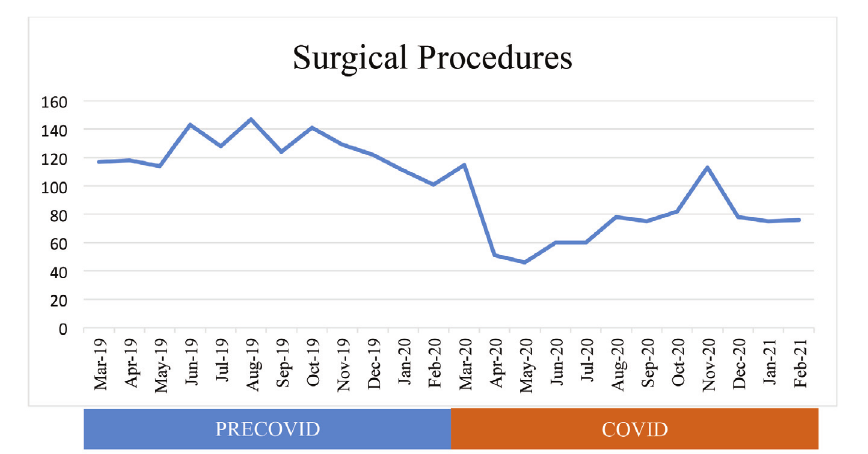
Fig. 3: Total surgical procedures in the lower extremity section of the Prof. Dr. R. Soeharso orthopaedic